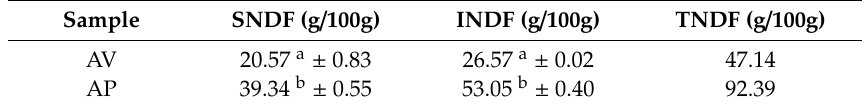
Table 3. Non-digestible fraction of Aloe vera gel (AV) and its polysaccharide extract (AP).